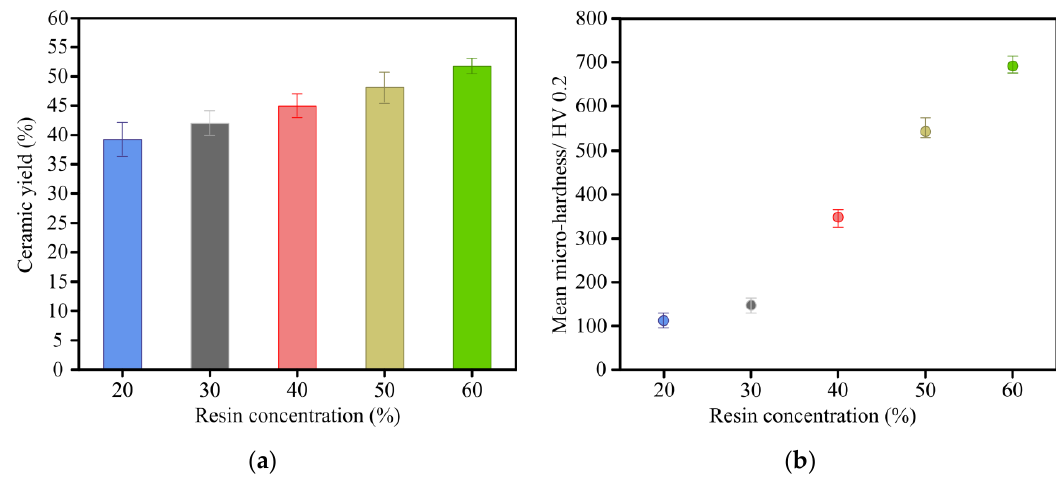
Figure 9. Experimental results of ( a ) ceramic yield and ( b ) micro-hardness of C WCMs with different resin concentration, under a constant filling rate of wood powder of 37.5%.